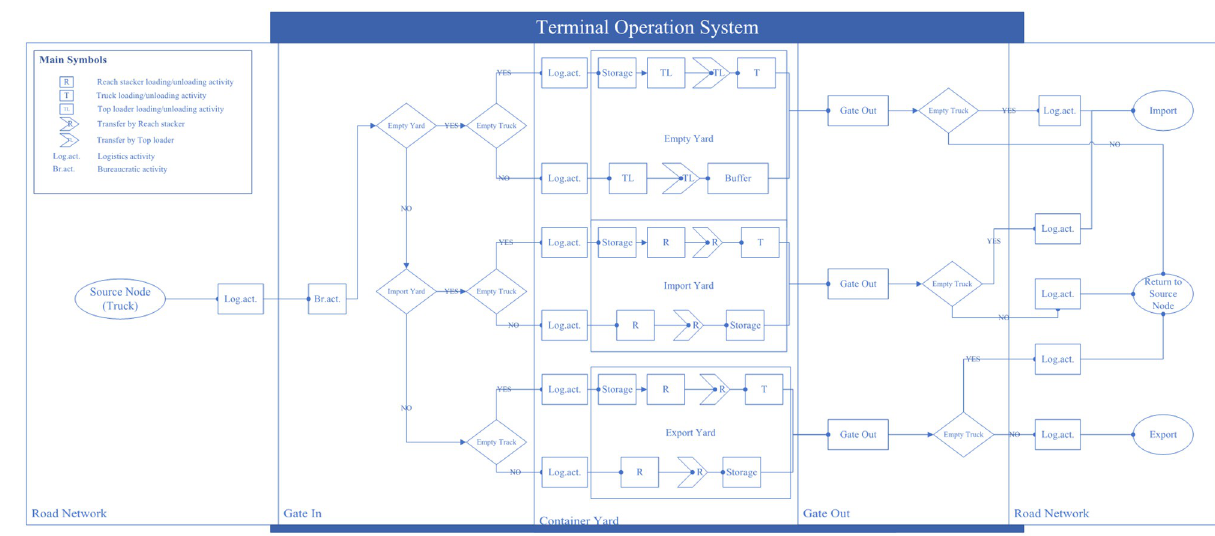
Fig 4. The detailed process for arriving and departing containers with no consolidation/ deconsolidation via road networks.